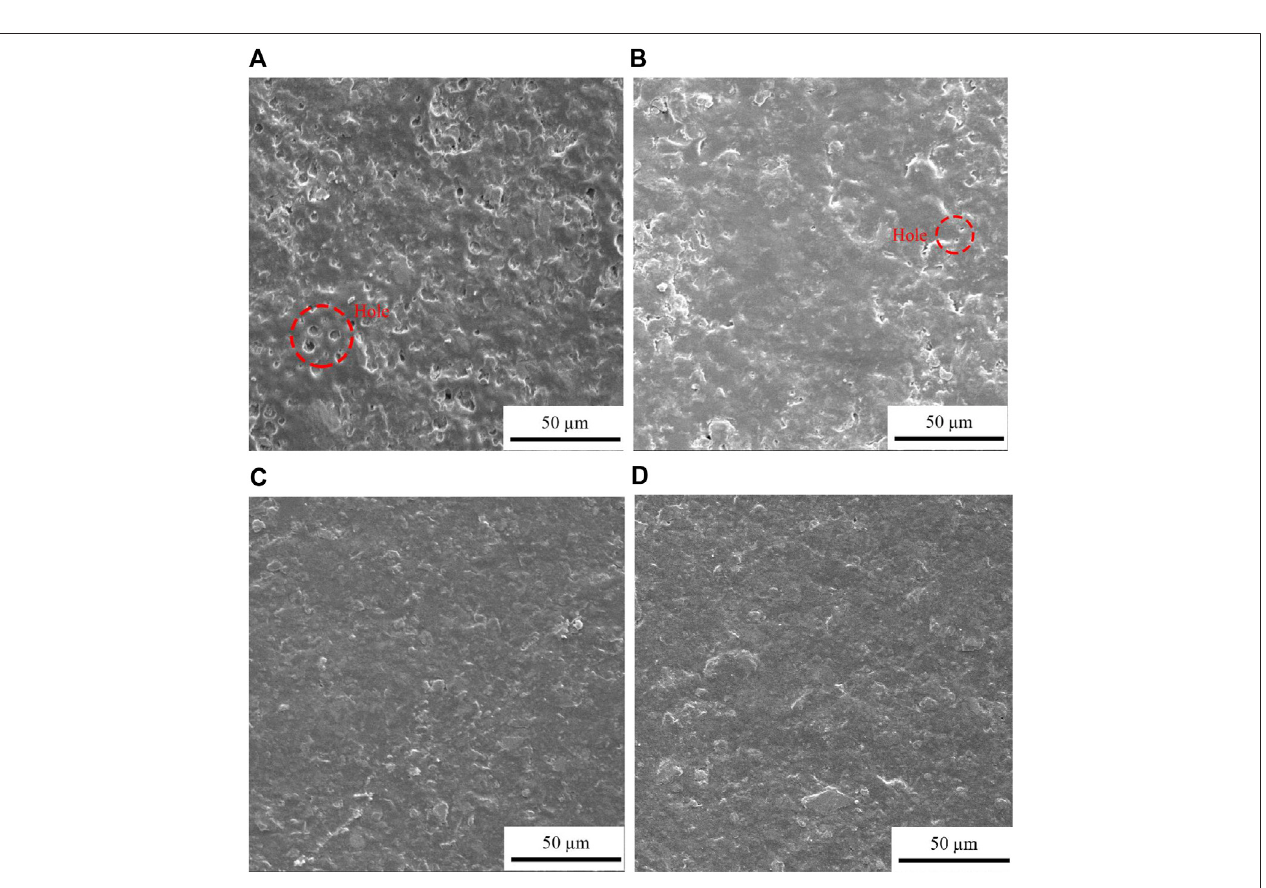
Frontiers in Materials |